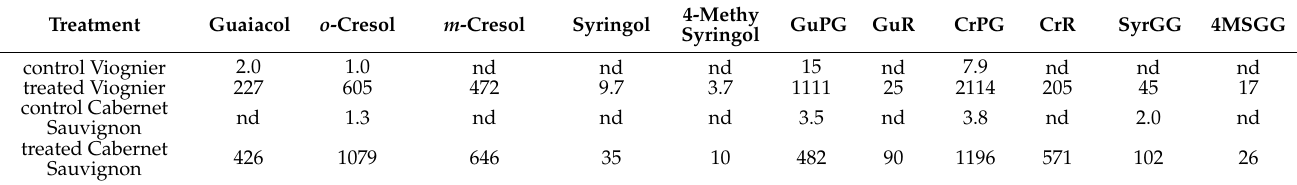
Table 3. Concentration of volatile phenols and their glycosides ( µ g/kg) in grapes exposed to volatile phenols for 60 h.